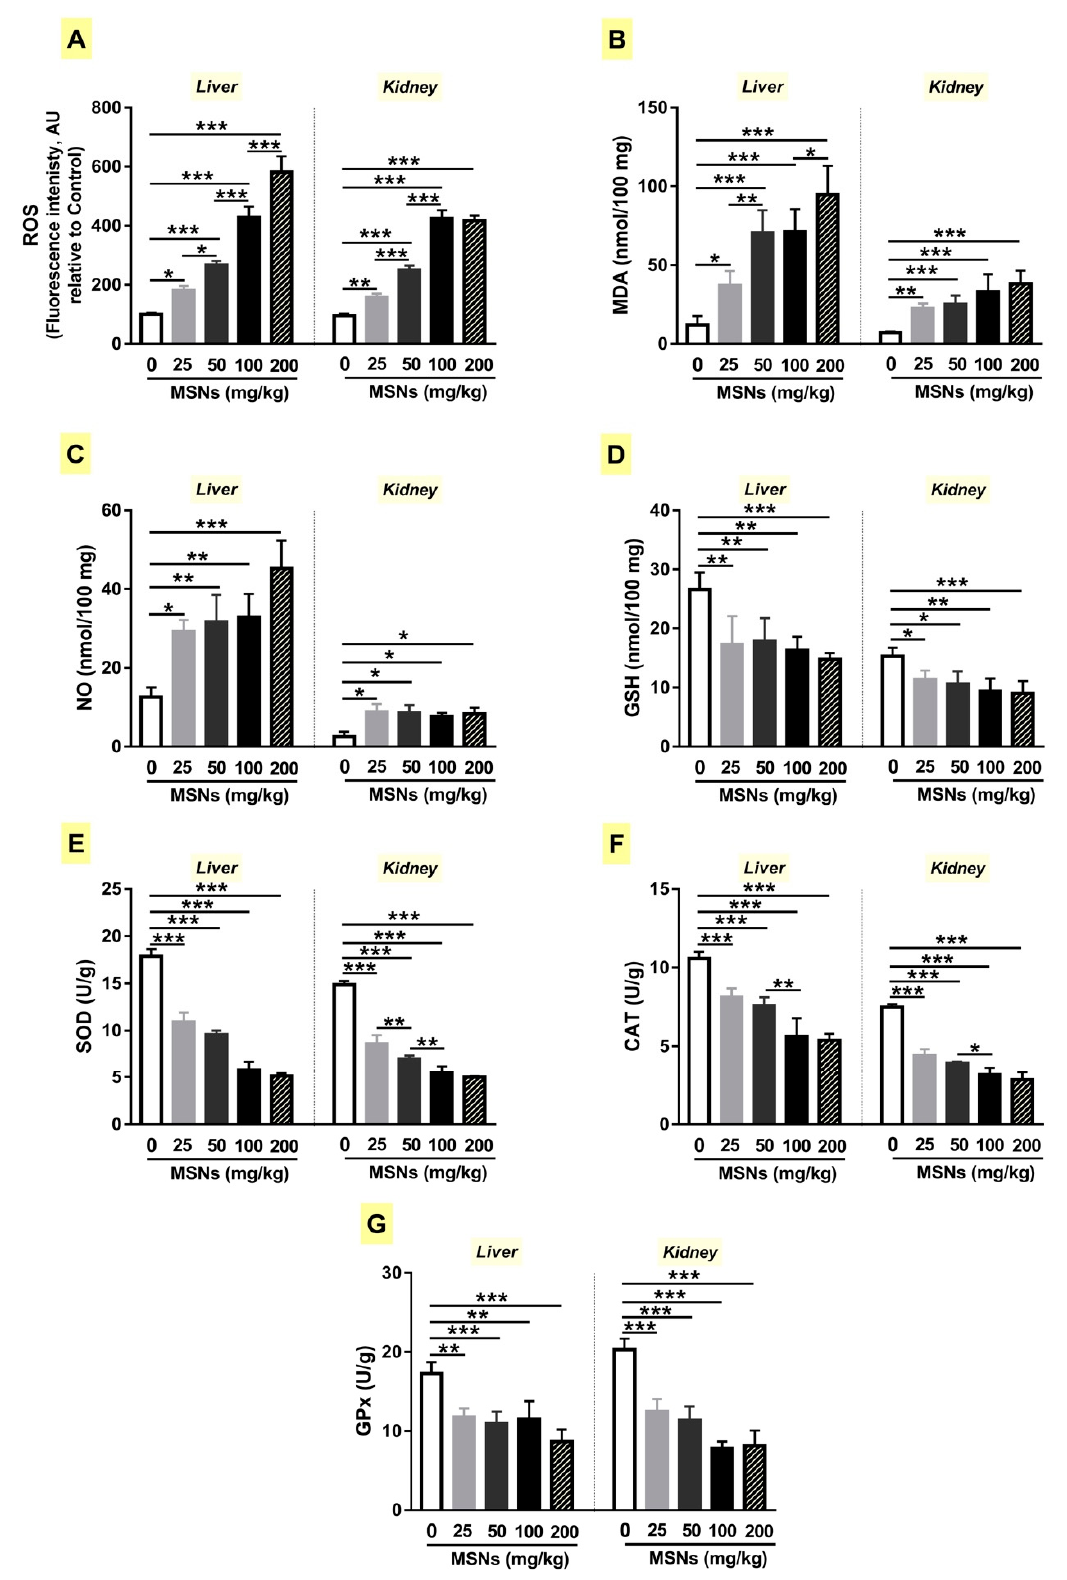
Figure 3. MSNs provoke reactive oxygen species (ROS) production and oxidative stress in liver and kidney of rats. MSNs increased ROS ( A ), malondialdehyde (MDA) ( B ) and nitric oxide (NO) ( C ), and diminished reduced glutathione (GSH) ( D ), superoxide dismutase (SOD) ( E ), catalase (CAT), ( F ) and glutathione peroxidase (GPx) ( G ). Data are Mean ± SEM ( n = 6). * p < 0.05, ** p < 0.01, and *** p < 0.001.